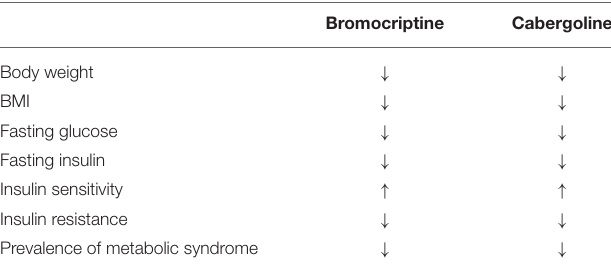
TABLE 1 | Effects of dopamine agonists bromoscriptine and cabergoline on metabolic abnormalities in patients with